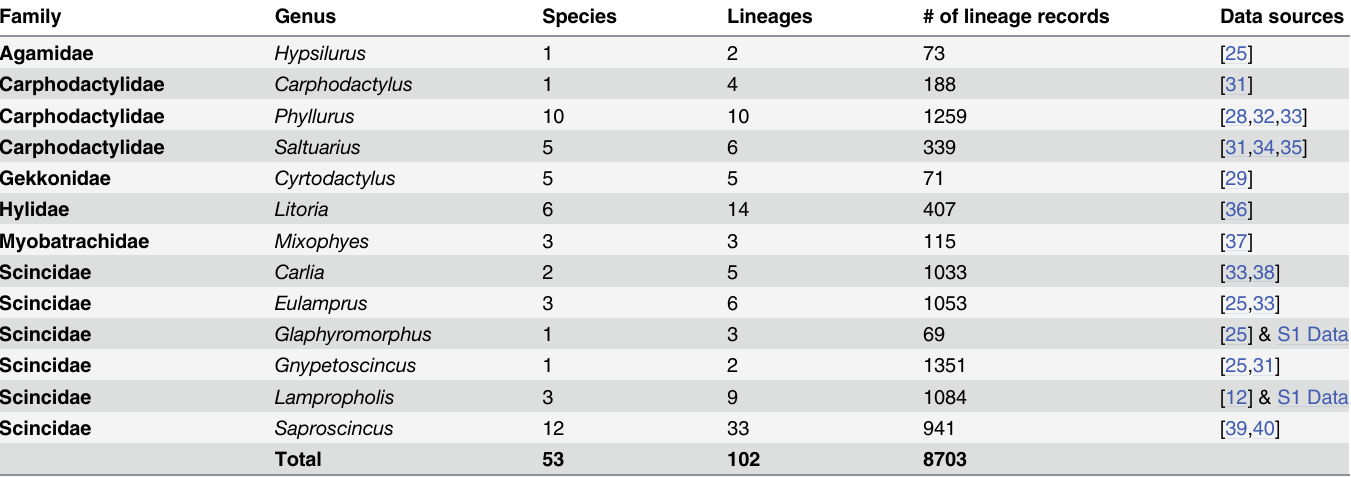
Table 1. Lineages of rainforest specialist lizards and frogs included in the